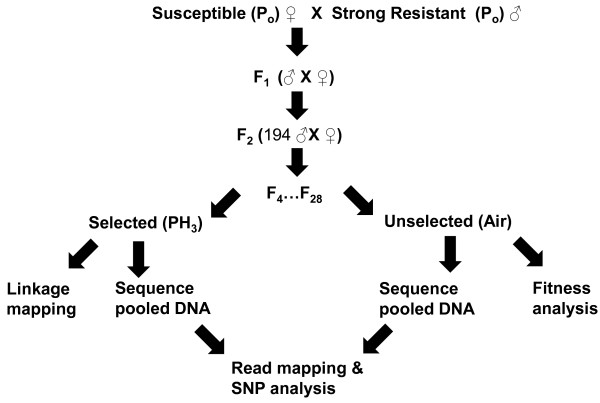
Outline of the crossing scheme and sequencing strategy.